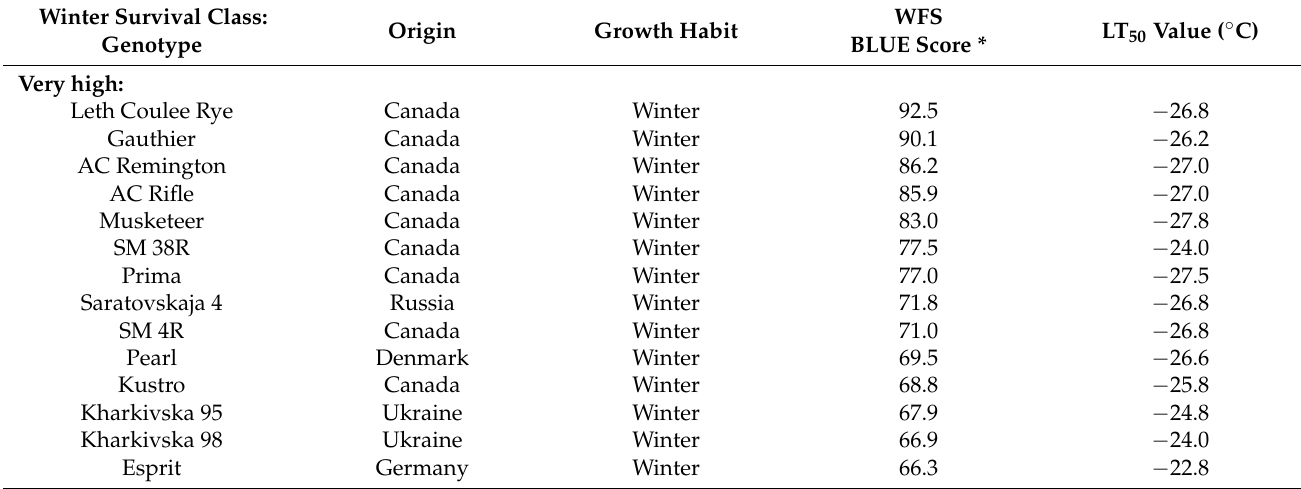
Table 1. Rye genotypes used in the study and their WFS and LT 50